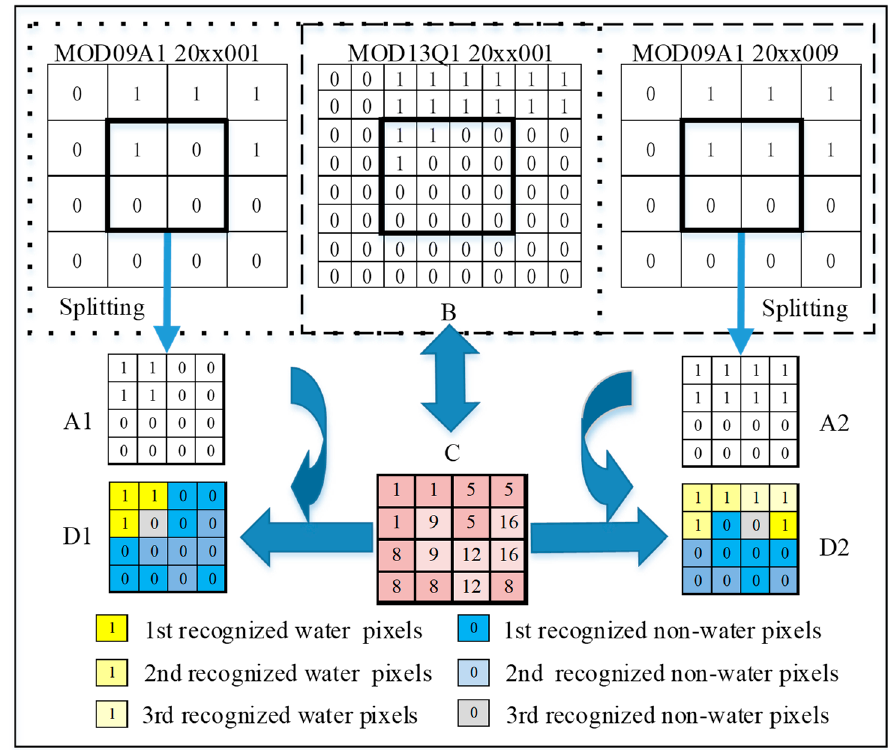
Figure 5. Fusion process of two sets of water results within 500 m every eight days and 250 m every 16 days. The pixels in the thick black box are the samples.